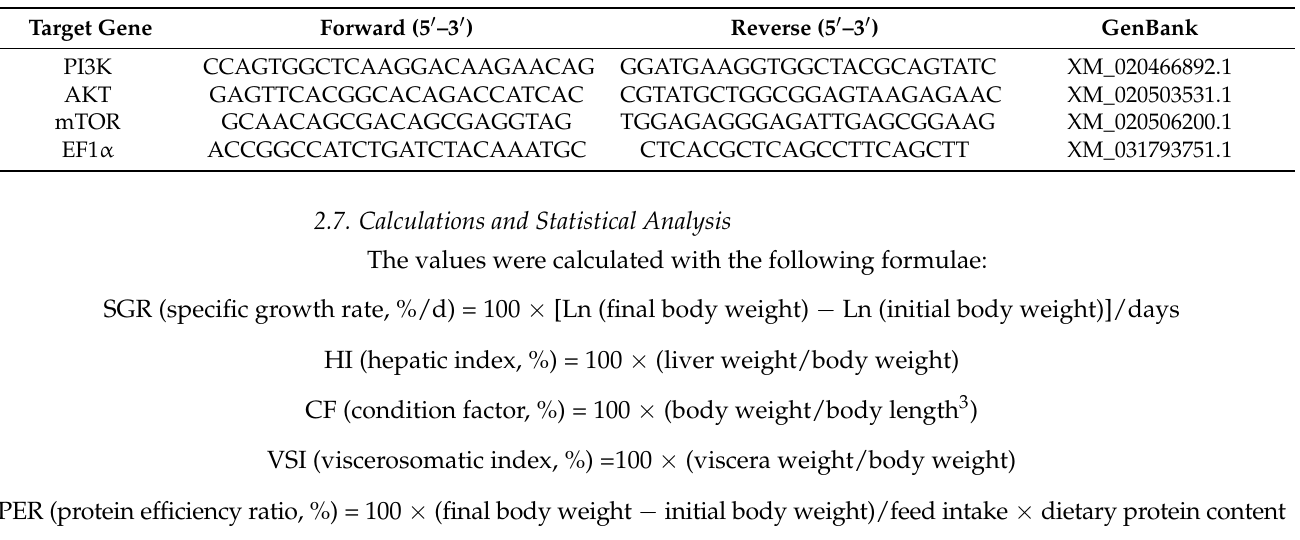
Table 2. Real-time quantitative PCR primers for target and reference